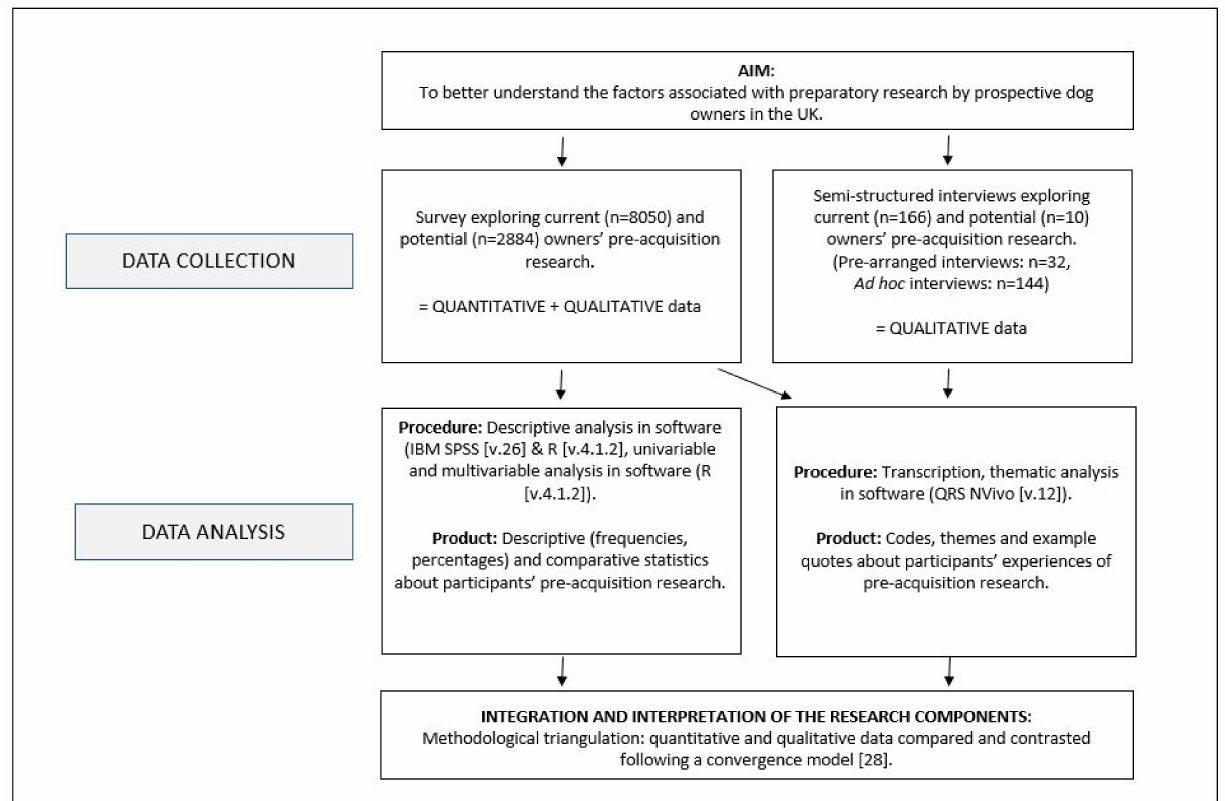
Figure 1. Procedural diagram of the mixed methods study design after Ref.